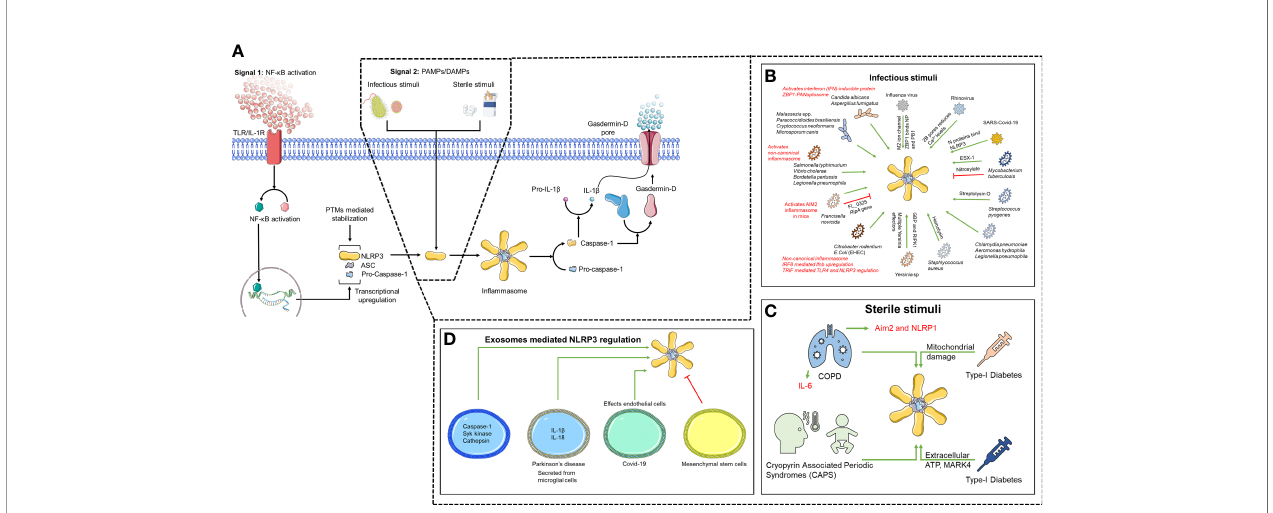
FIGURE 1 | Two-step mechanism of NLRP3 activation. (A) TLR/IL1-R engagement leads to NF- k B activation driving transcriptional upregulation of in fl ammasome components (Signal 1). NLRP3 is then activated upon sensing unknown direct agonists (Signal 2), which can be (B) infectious, (C) sterile and can also be mediated through (D)